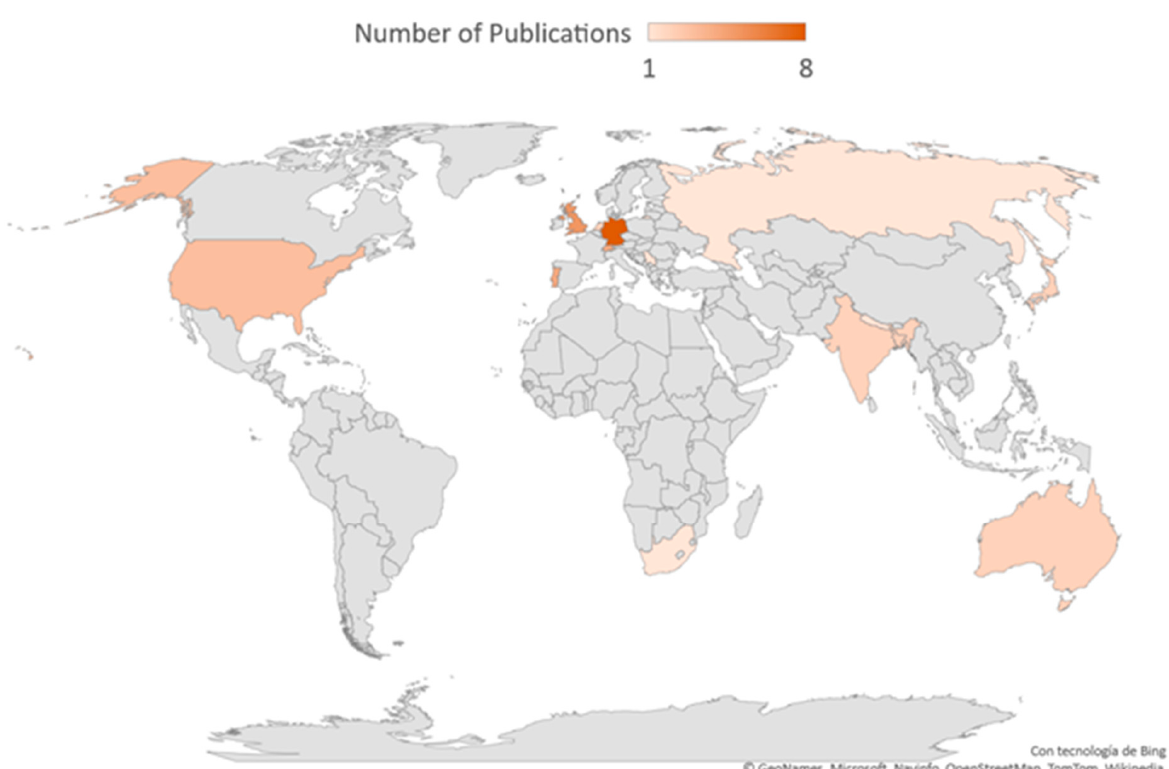
Figure 2. Geographical distribution of current research studies.